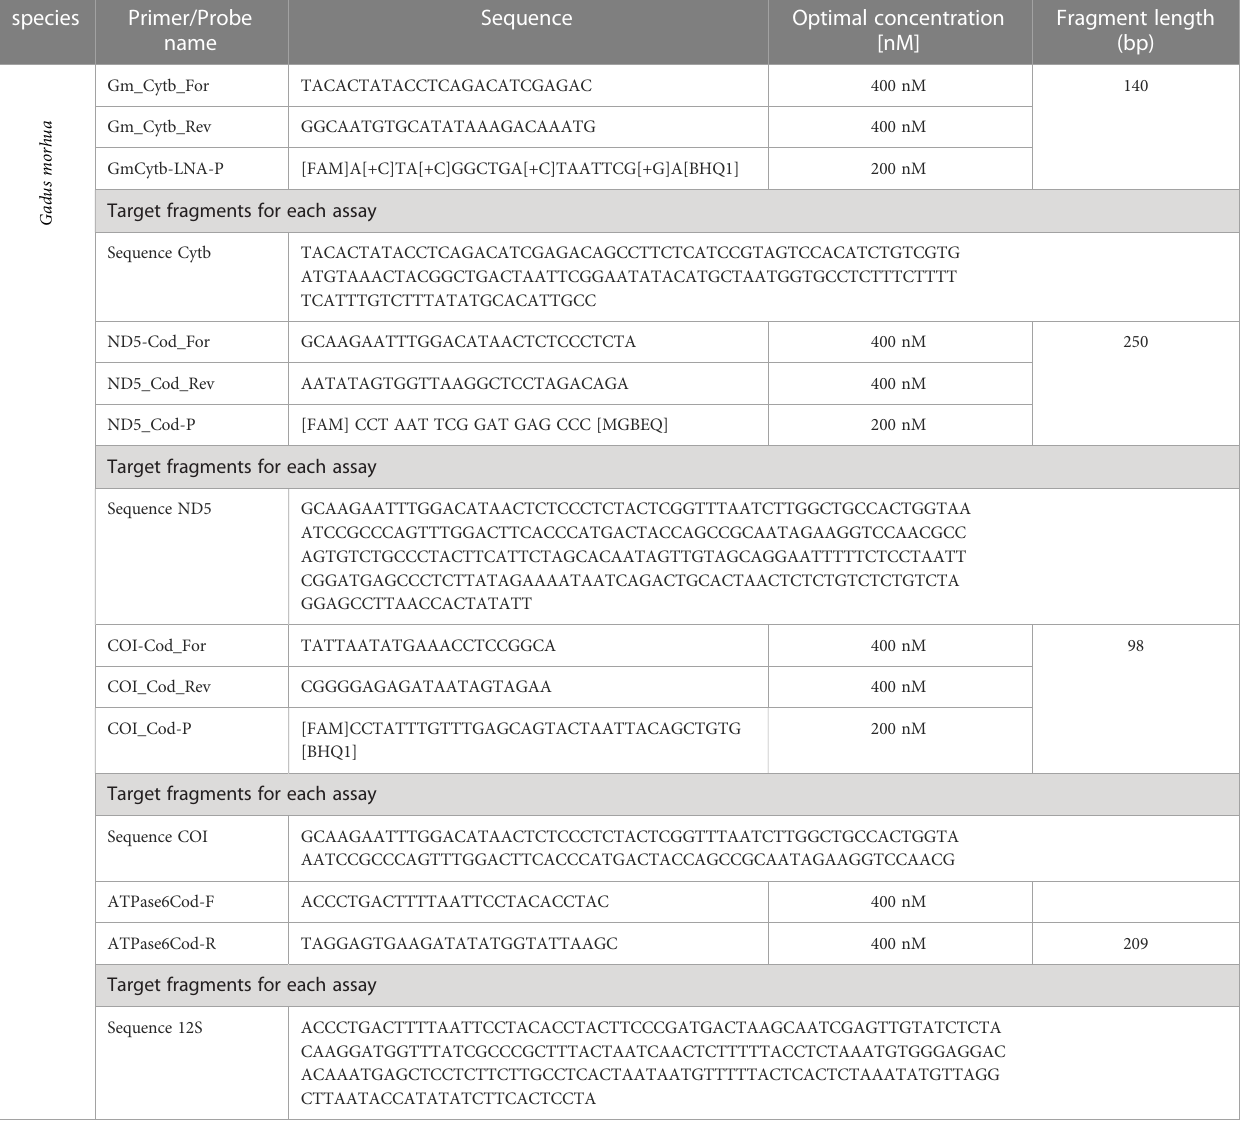
TABLE 2 List of primers/probes pairs developed and tested, with the optimal concentrations and lengths of target fragments.